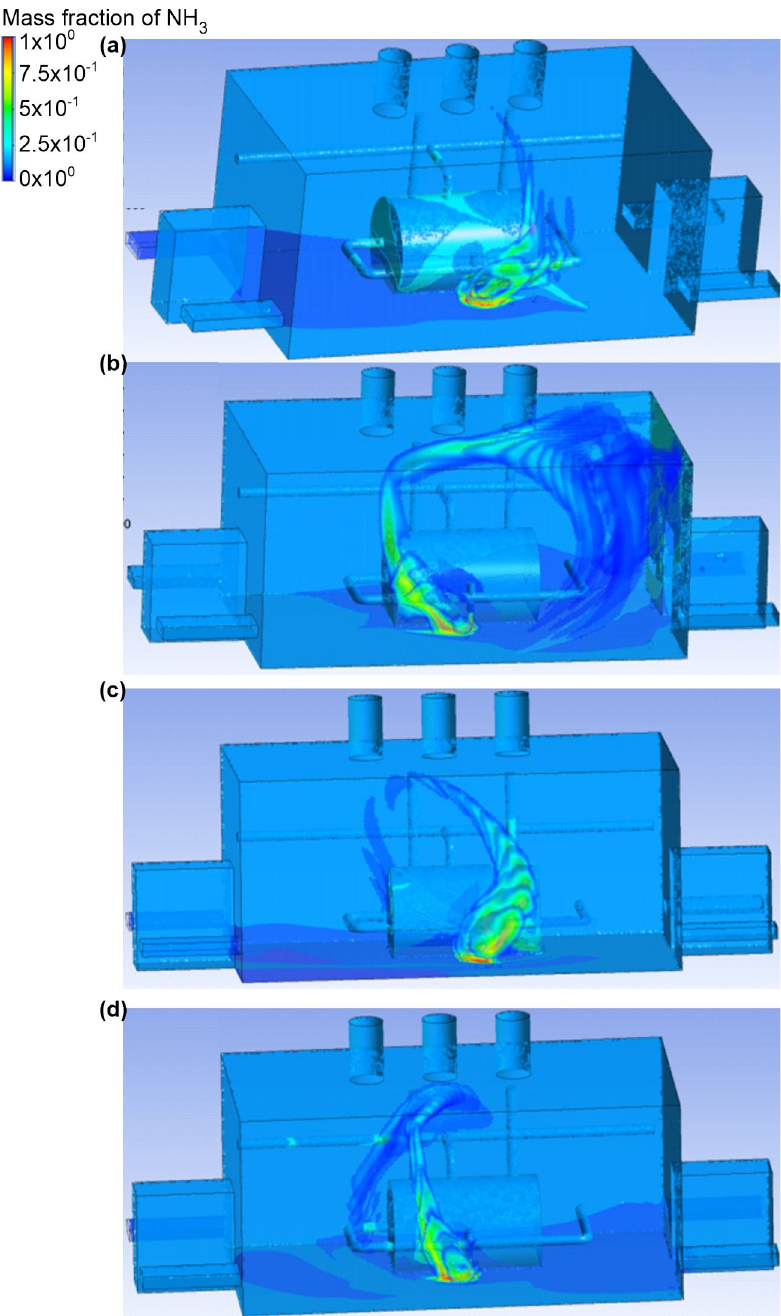
Figure 6. Ammonia distribution in the engine room for: ( a ) scenario A, ( b ) scenario B, ( c ) scenario C, and ( d ) scenario D.